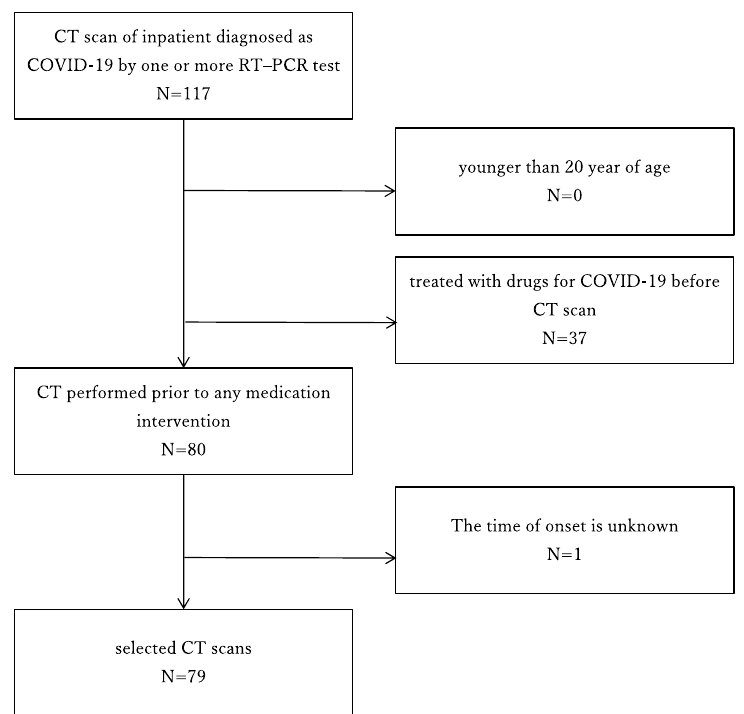
Figure 1. Flow chart of patient selection. CT: computed tomography; COVID-19: coronavirus disease 2019; RT-PCR: reverse transcription–polymerase chain reaction.